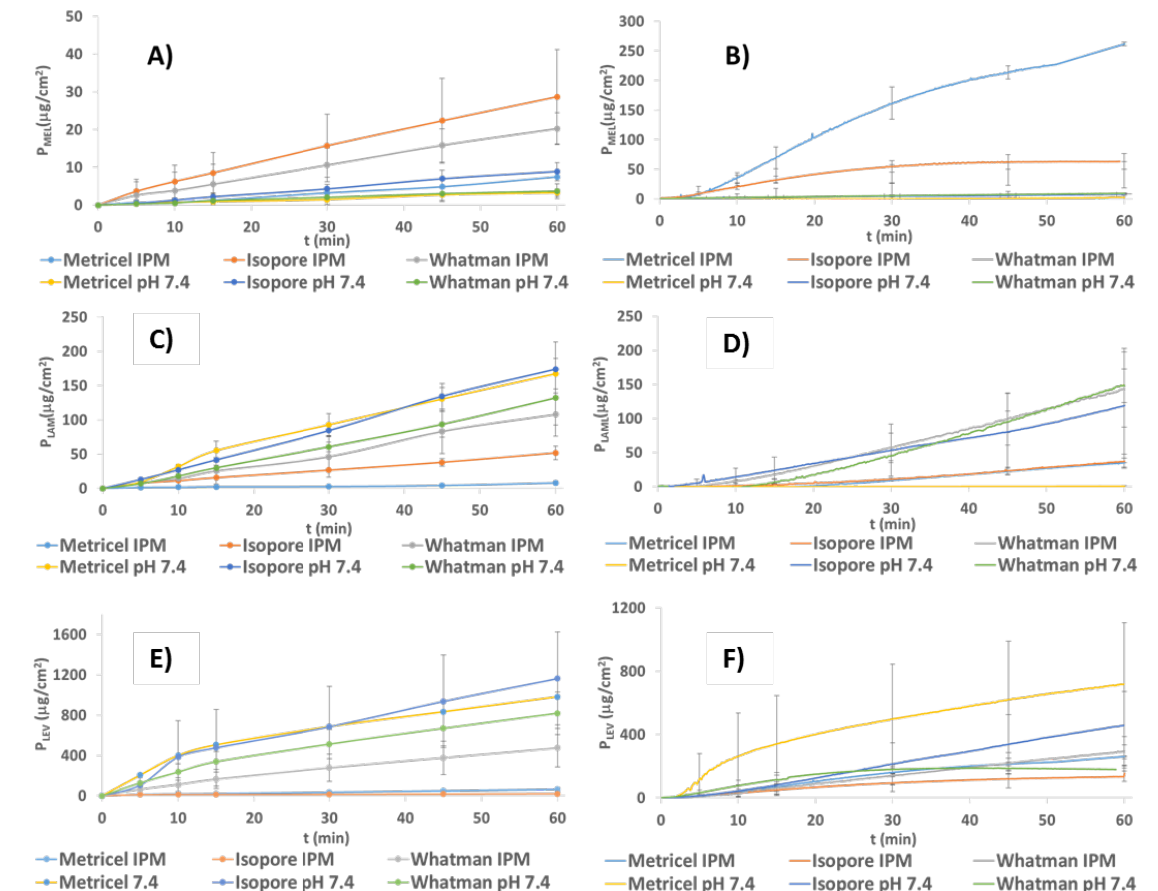
Figure 5. Penetration of MEL through different membranes during offline ( A ) and inline measurements ( B ), LAM during offline ( C ) and inline measurements ( D ), and LEV during offline ( E ) and inline measurements ( F ) via soaking in PBS or in IPM. Table 6. Penetration extent ( µ g/cm 2 ) of MEL, LAM, and LEV at 15 min of